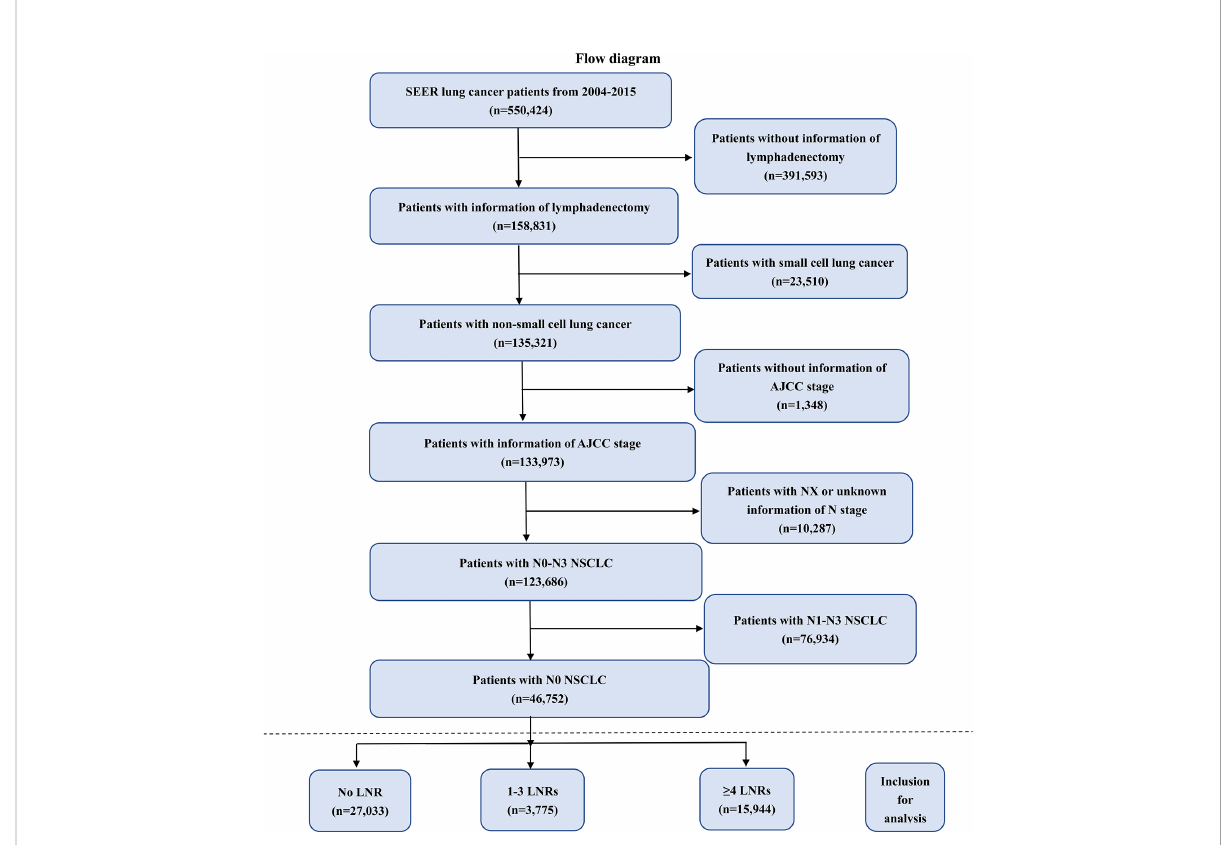
FIGURE 1 Flow chart of patient screening. NSCLC, non-small lung cancer; SEER, the Surveillance, Epidemiology, and End Results database; AJCC, American Joint Committee on Cancer; LNRs, lymph nodes